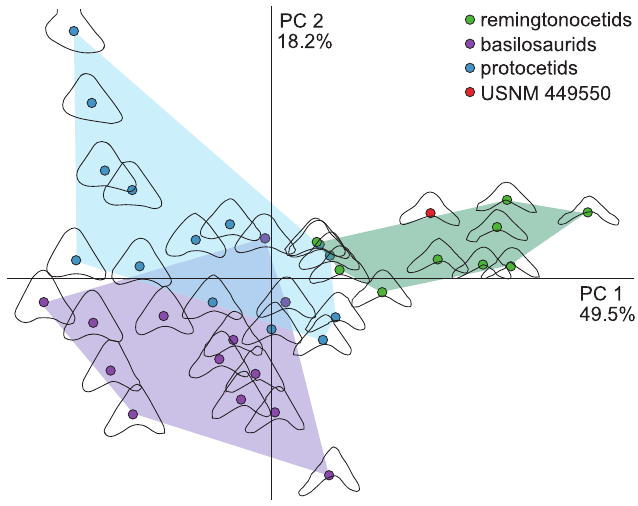
Fig. 1. PCA ordinations of differences in tooth morphology for sampled archaeocetes. This plot includes data from both adult and deciduous pre- molars. The numbers next to the axis labels indicate the percentage of ex- plained variation in morphology for that axis. The tooth shapes around each point represent the outline generated using the harmonic coefficients produced by elliptic Fourier analysis to achieve 99.9% harmonic power. See SOM: table 1 for a list of included